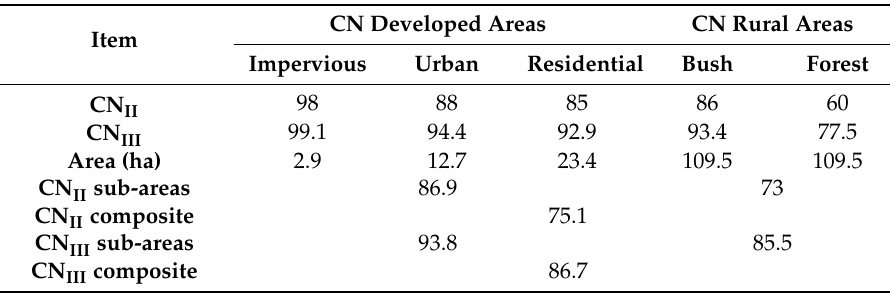
Table 7. Composite CN for Gordo creek